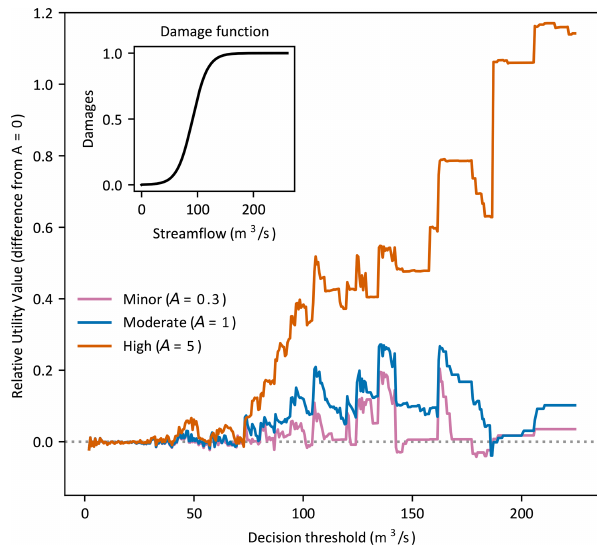
Figure 8. Difference in RUV between risk-averse ( A > 0) and risk- neutral ( A = 0) users ( y axis) for a binary decision at a single α value ( α = 0 . 2). The binary decision threshold ( x axis) is var- ied from 2–225m 3 s − 1 and decisions are made using the optimisa- tion approach with subseasonal forecasts from the first week of lead